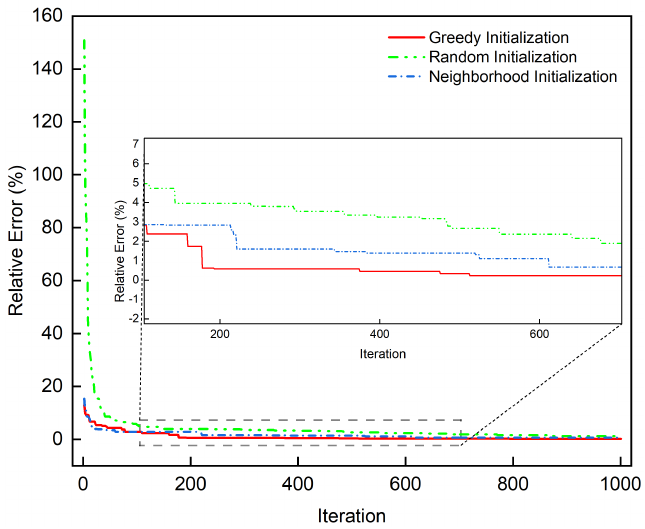
Figure 8. RE curves with random initialization, neighborhood initialization, and greedy initialization for different iteration periods based on eil101.